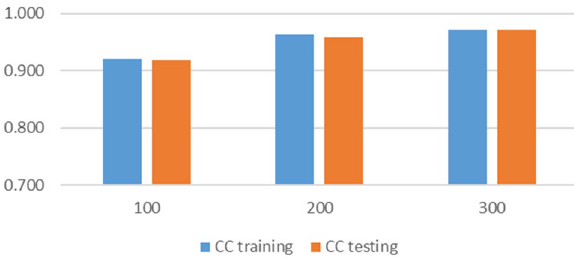
Figure 11. Sensitivity analysis on the number of iterations.